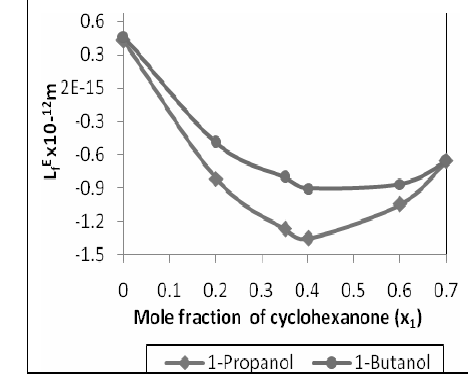
Figure 1. Variation of excess adiabatic compressibility versus mole fraction of cyclohexanone (X ) 1